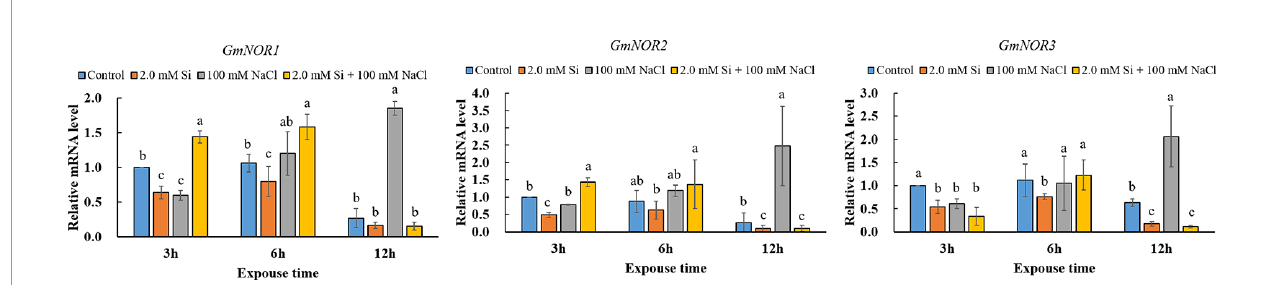
FIGURE 7 | Relative mRNA expression level of SNO-related genes ( GmNOR1 , GmNOR2 , GmNOR3 ) after single or combined Si and NaCl. Data were collected at 3, 6, and 12 h after stress exposure. Different letters above error bars indicate signi fi cant differences by Duncan's multiple range test ( P < 0.05). Data were collected in triplicate and are presented as the average ± standard error ( n